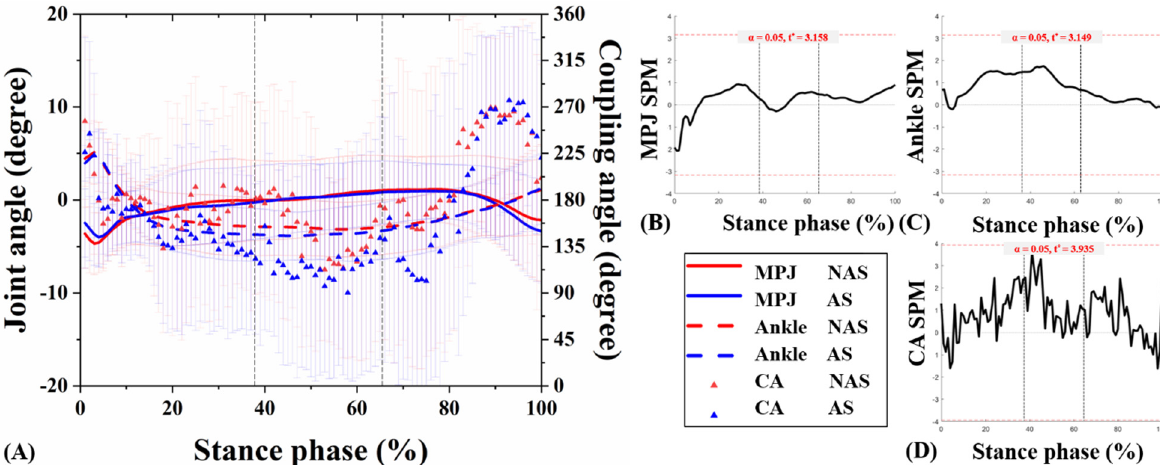
Figure 5. Angles curves of the ankle and MPJ, and mean CA for MPJ-ankle in the frontal plane ( A ). The SPM results between NAS and AS during UGT, depicting the MPJ angle ( B ), ankle angle ( C ), and CA ( D ).